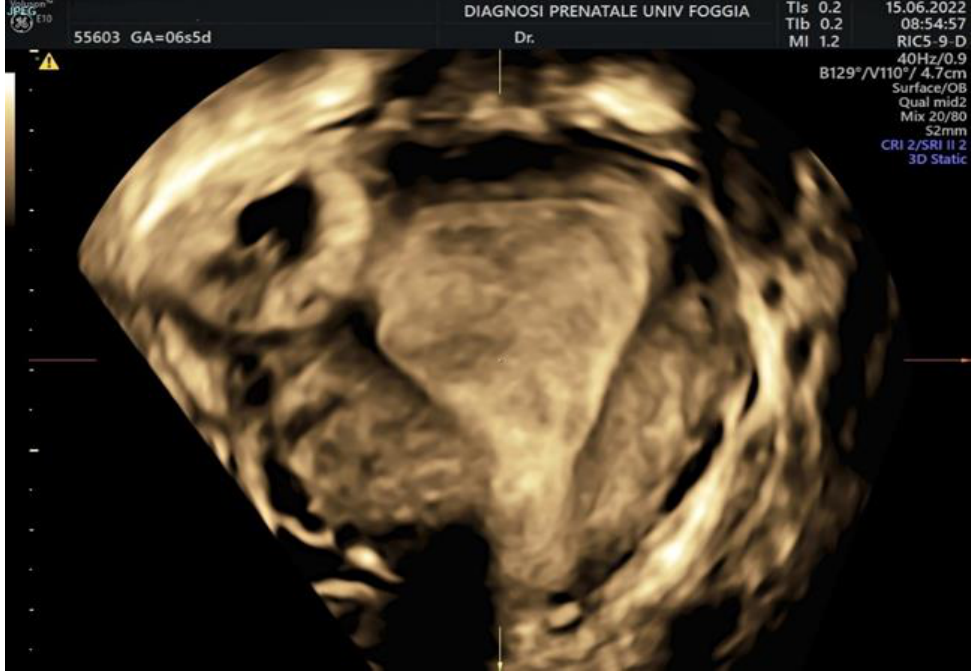
Figure 3. 3D transvaginal ultrasound showing the interstitial pregnancy .